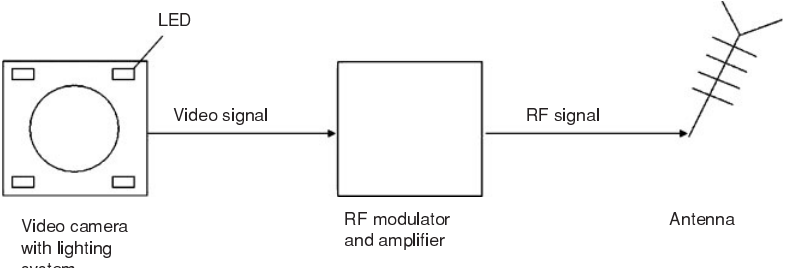
Figure 2 Prototype design of WCE, which includes (1) a video camera, (2) an RF modulator, (3) an antenna and (4) a lighting system. LED is light-emitting